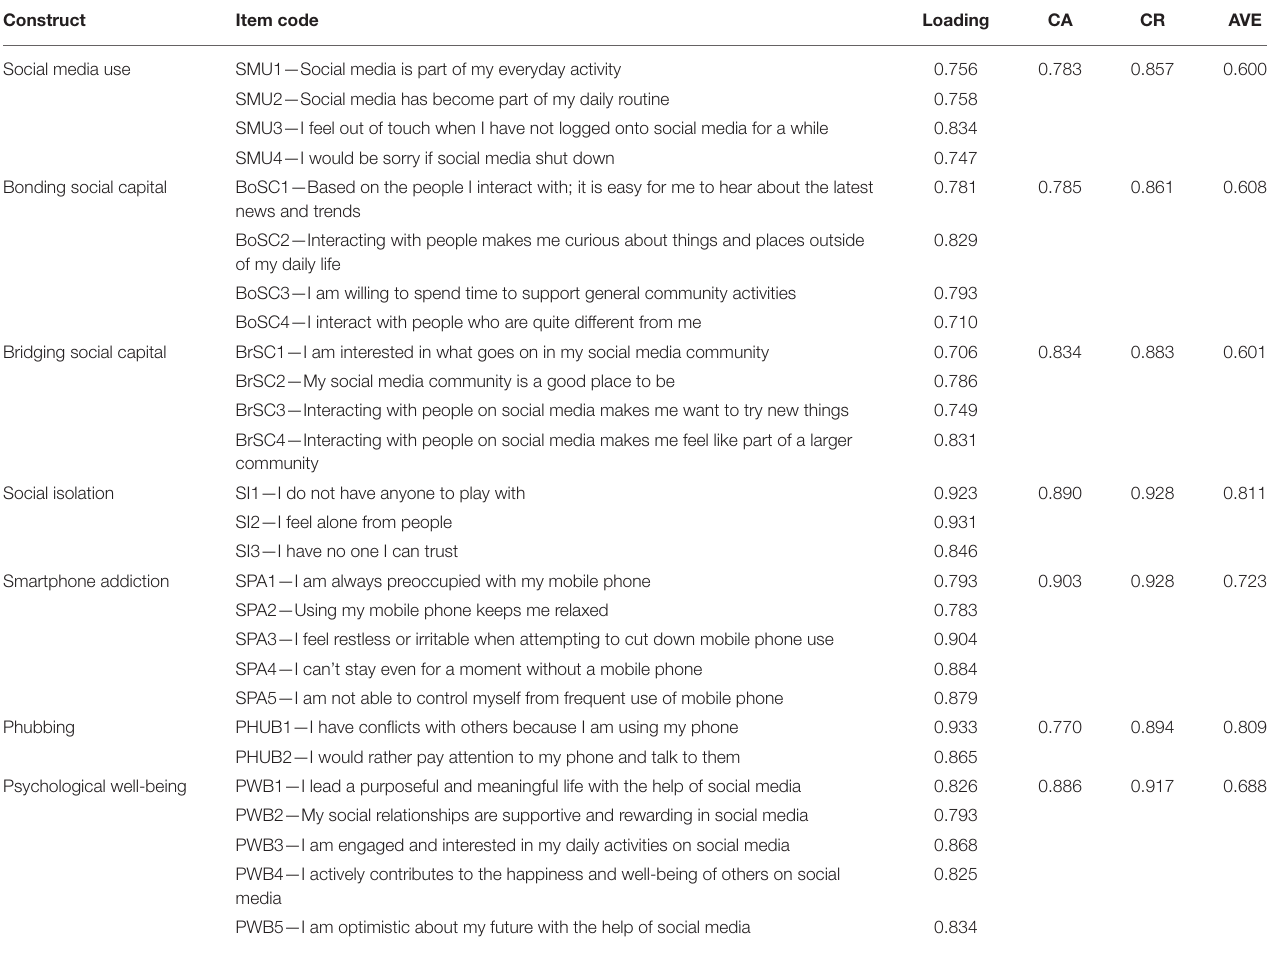
TABLE 3 | Study measures, factor loading, and the constructs’ reliability and convergent